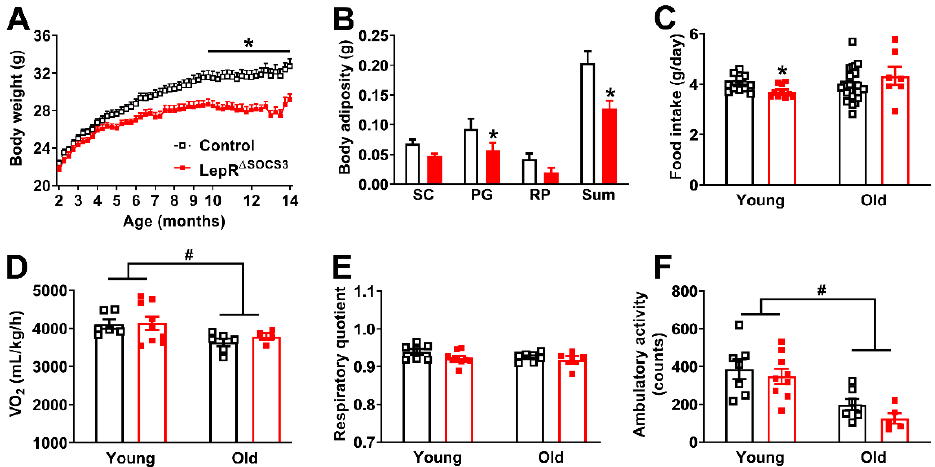
Figure 1. Reduced aging-induced weight gain in LepR ∆ SOCS3 mice. ( A ) Changes in body weight along time in control ( n = 26–27) and LepR ∆ SOCS3 ( n = 12–24) mice. ( B ) Masses of the subcutaneous (SC), perigonadal (PG) and retroperitoneal (RP) fat pads and the sum of these deposits in control (black column; n = 11) and LepR ∆ SOCS3 (red column; n = 10) mice. ( C ) Food intake in young adult (3-month-old; n = 10–11/group) and middle-aged (15-month-old; n = 7–26/group) mice. ( D – F ) Oxygen consumption (VO 2 ), respiratory quotient and ambulatory activity in young adult ( n = 7–9/group) and middle-aged ( n = 5–7/group) mice. Mean ± SEM. * p < 0.05 control vs. LepR ∆ SOCS3 (post-hoc test two-way ANOVA). # p < 0.05 age effect (two-way ANOVA).